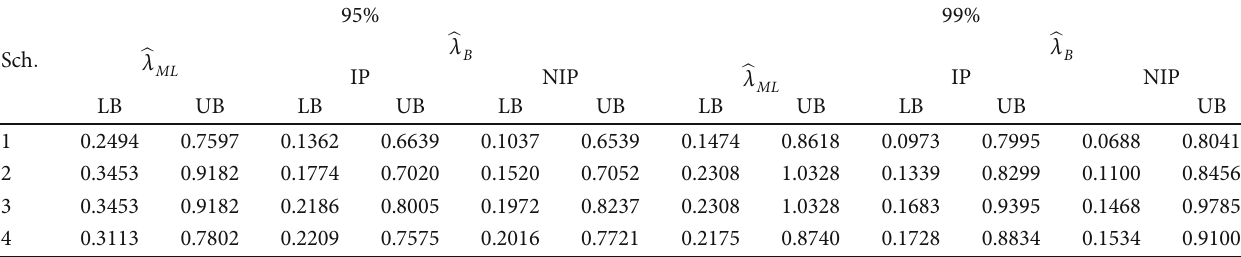
Table 8: The 95 % and 99 % con fi dence intervals estimates of λ based on the di ff erent Type-II uni fi ed PHCSs from real data. 95 Sch :